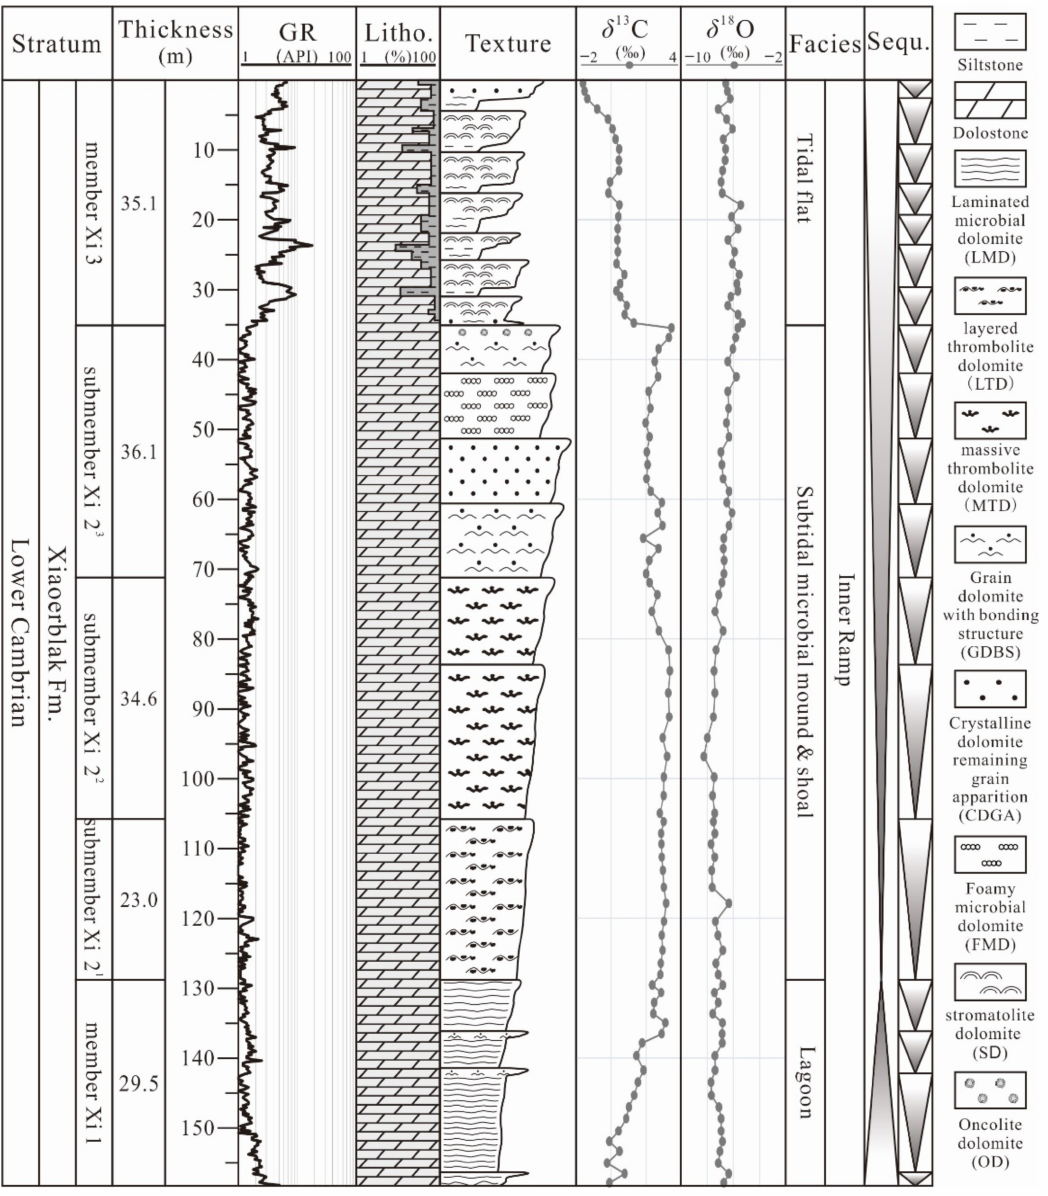
Figure 2. Stratigraphic column of Xiaoerblak